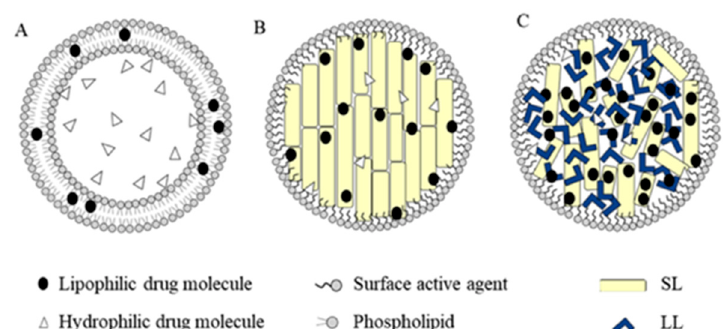
Figure 3. Different types of lipid-based nanoparticles. ( A ) Liposomes; ( B ) solid lipid nanoparticles (SLNs); ( C ) nanostructured lipid carriers (NLCs) [70].